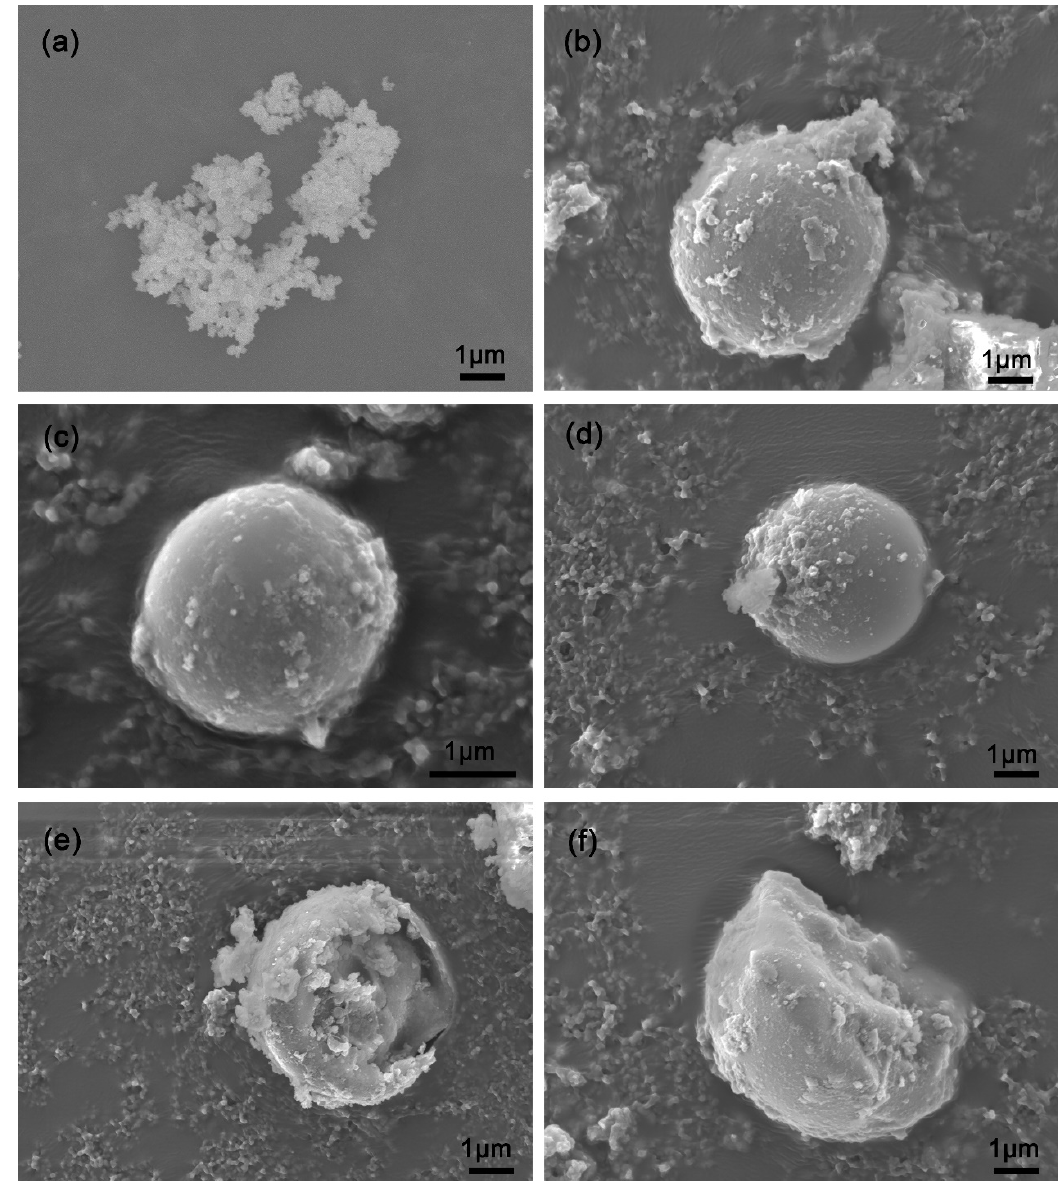
Figure 1. SEM images of ( a ) P-silica, ( b ) FS-5.3, ( c ) FS-6.3, ( d ) FS-7.3, ( e ) FS-8.3, ( f ) FS-9.3.